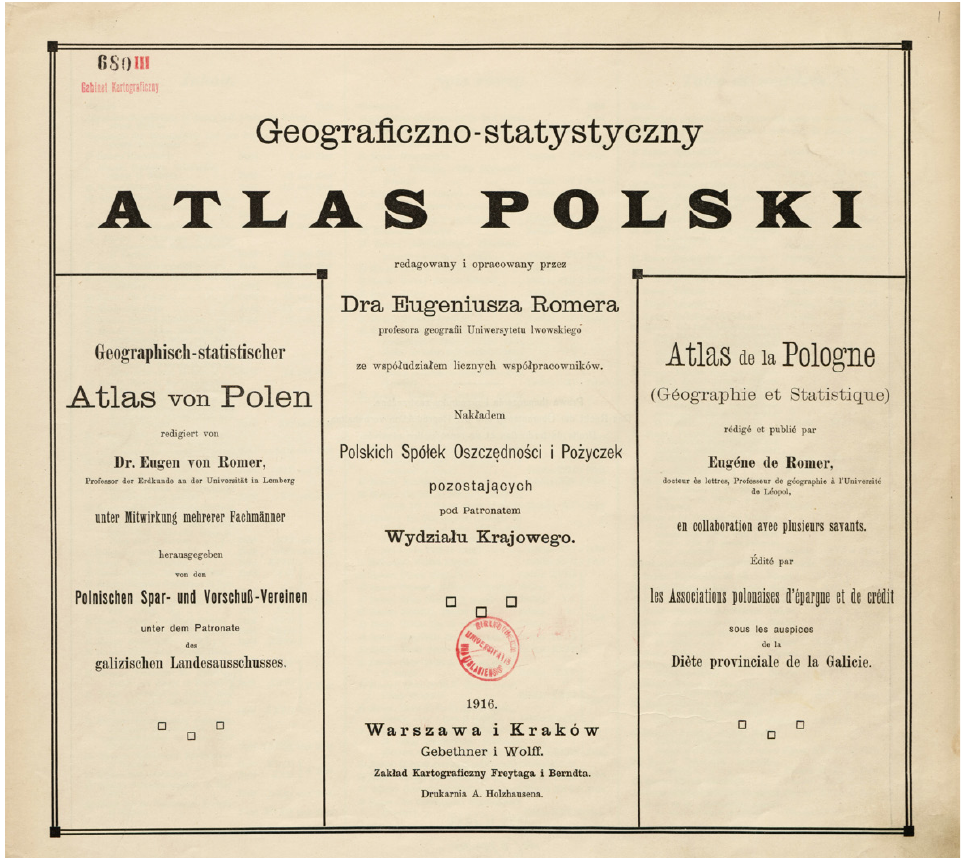
Fig. 1. Title page of the Geographical and Statistical Atlas of Poland by E. Romer, the 1st edition,